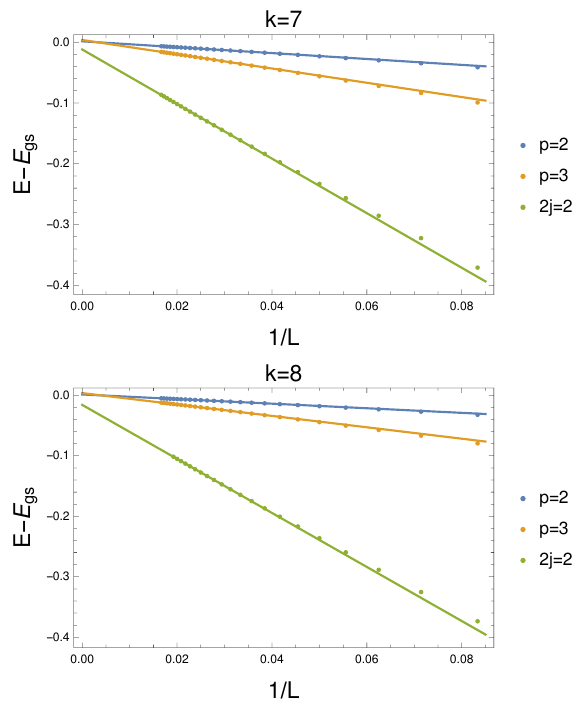
Figure 3: Gaps associated to the low-lying levels at the point θ , obtained by numerical TL resolution of the Bethe ansatz equations, plotted as a function of 1 / L . The blue and orange dots correspond to gaps between the lowest lying levels in the (cid:86) sector with p = 2,3 and 0, p the ground state of the anyonic chain (lying in the (cid:86) sector). The green dots correspond 0, p = 1 to a magnetic excitation, namely the lowest level of the (cid:86) sector. Solid lines correspond 2 j = 2,0 = a + b / L of the largest size data. While for the magnetic excitation to fits of the form E − E gs the gap remains finite in the L → ∞ limit, for the (cid:86) excitations it vanishes as 1 / L 0, p